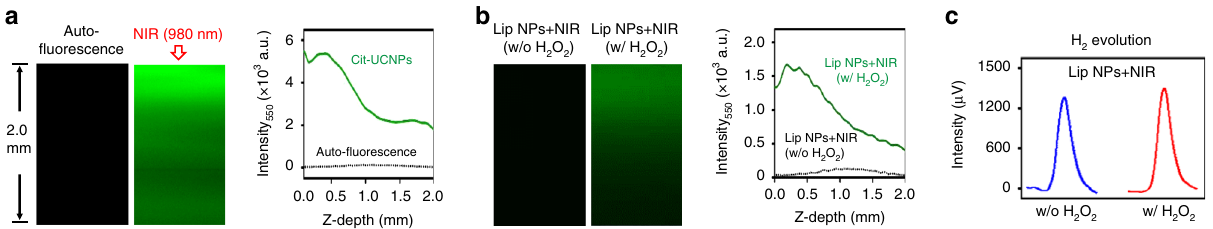
Fig. 7 Ex vivo ROS detection and H 2 generation. a Fluorescence images and intensities of tissue auto fl uorescence and NIR light propagation in porcine skin tissue injected with Cit-UCNPs. b Fluorescence images and intensities of NIR light propagation in porcine skin tissues injected with Lip NPs in absence/presence of H 2 O 2 and c their H 2 evolution pro fi les. Source data are provided as Source Data